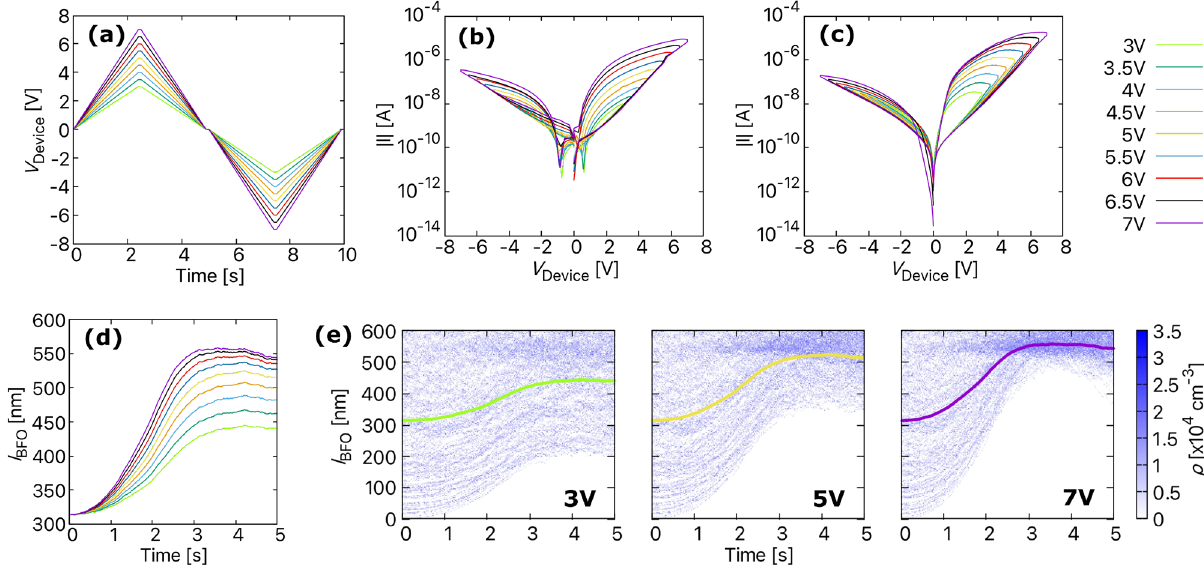
Figure 7. ( a ) Input voltage source ( V Device ) with different amplitudes. ( b ) Experimental I – V curves, and ( c ) simulated I – V curves for different maximum V Device . ( d ) The change in average distance positive applied voltage cycle with different amplitudes. ( e ) The change in charge density over time for a positive applied voltage cycle with maximum voltage of 3 V, 5 V and 7 V. The legend for all plots is shown on the top right